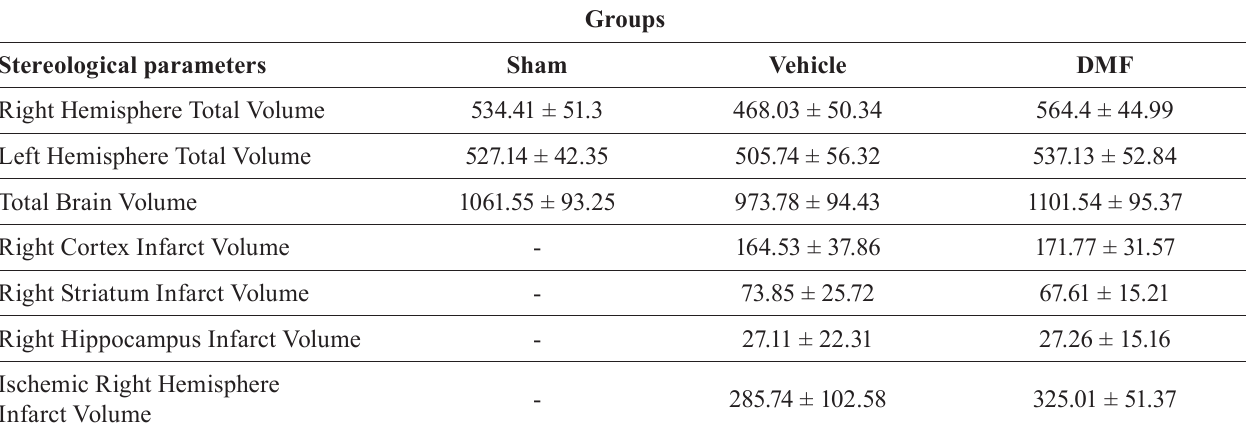
TABLE II - The total and infarct volume (mean ± SD) of the different parts of the brain (mm 3 )